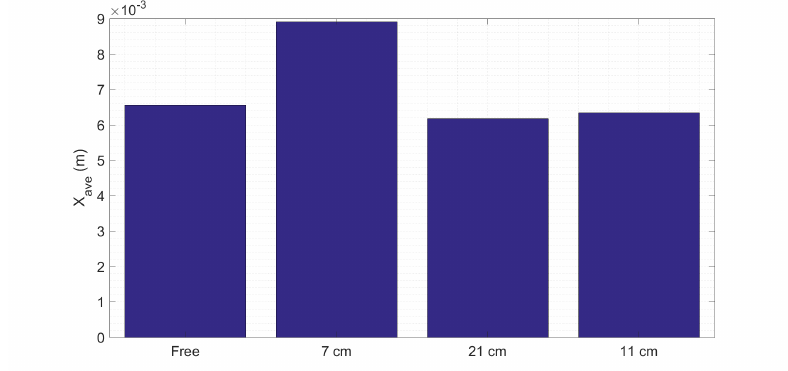
Figure 8. Structure displacement versus various filling levels in the first 10 sonds.